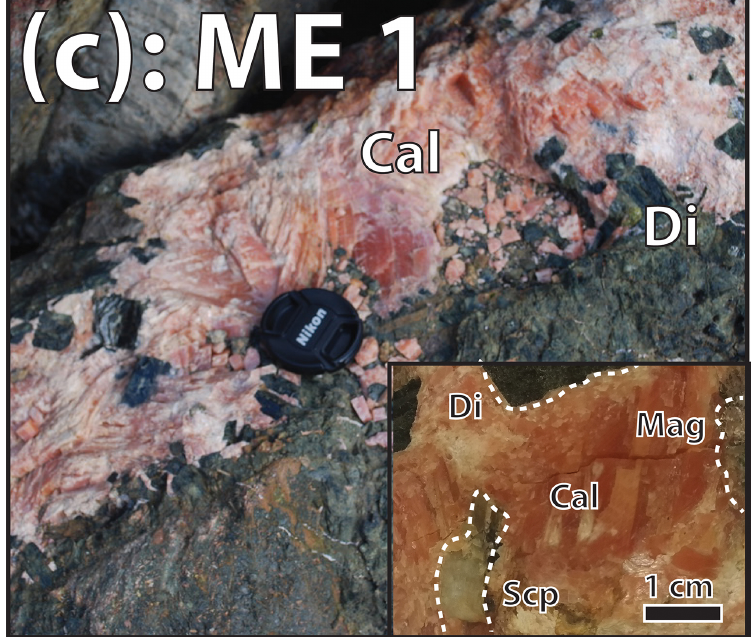
https://doi.org/10.5194/gchron-4-353-2022 Geochronology, 4, 353–372,